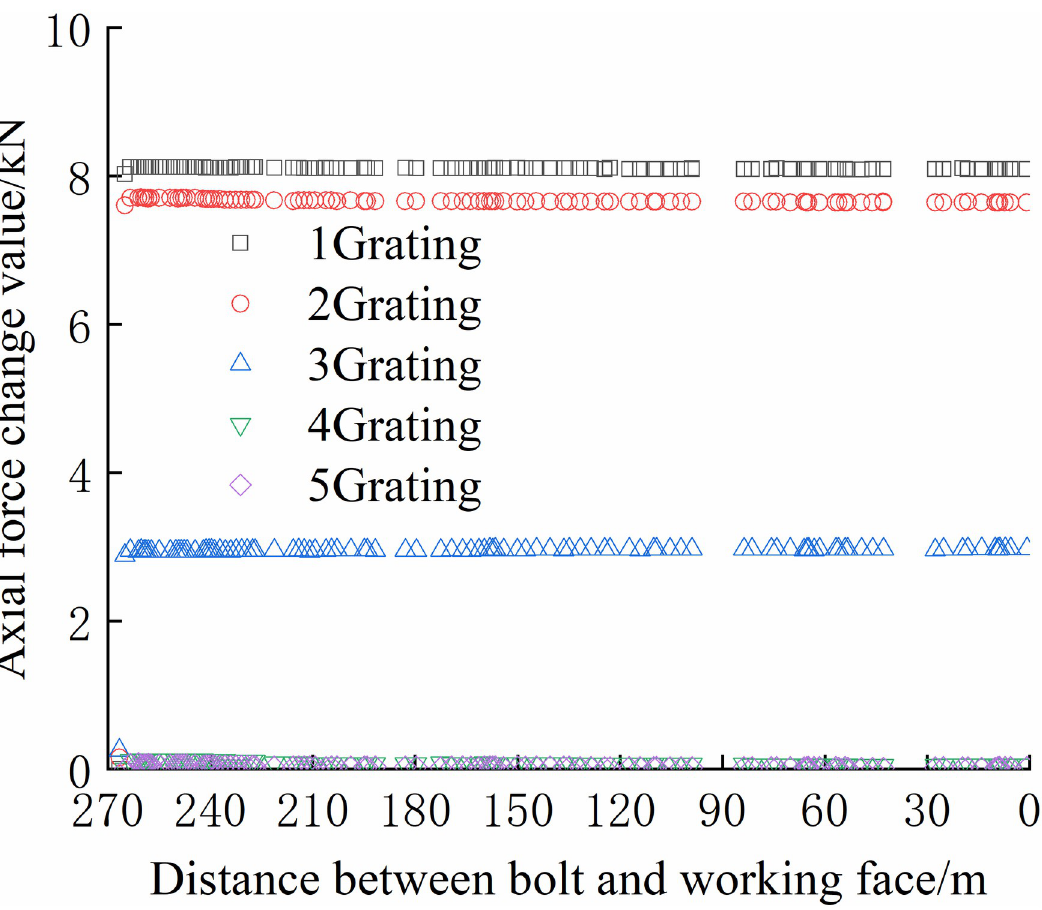
Fig 32. Axial force monitoring test curve of No. 9 bolt.